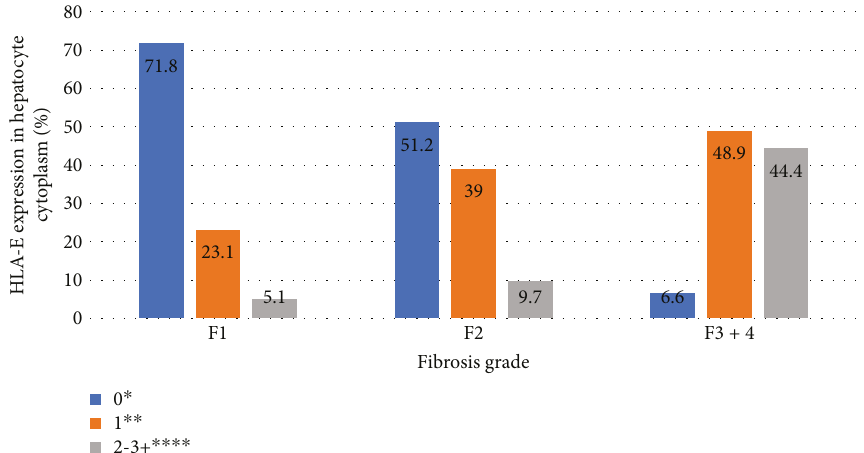
Figure 2: Association between HLA-E expression in hepatocyte cytoplasm and liver fi brosis. HLA-E expression was described in the following grades: 0 ∗ (without positive cell expression), 1+ ∗∗ ( < 25%), 2-3+ ∗∗∗∗ ( > 25 or > 50% of positive cell expression). Liver fi brosis was described according to the METAVIR classi fi cation: F1: portal fi brosis without septa, F2: portal fi brosis with rare septa, F3-4: numerous septa without and with cirrhosis. P < 0 001